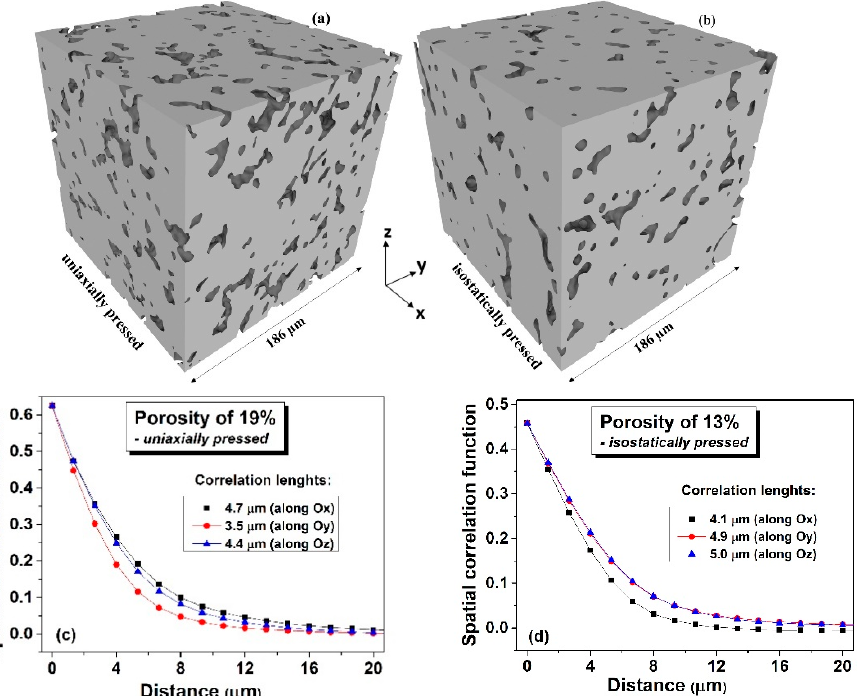
Figure 2. 3D images of the processed BaTiO 3 ceramics structures derived by micro X-ray computed tomography of with a relative porosity of ~19%, uniaxially pressed ( a ) and with a relative porosity of ~13%, isostatically pressed ( b ); ( c , d ) Correlation functions along the main local axes for the structures shown in the figures ( a , b ).